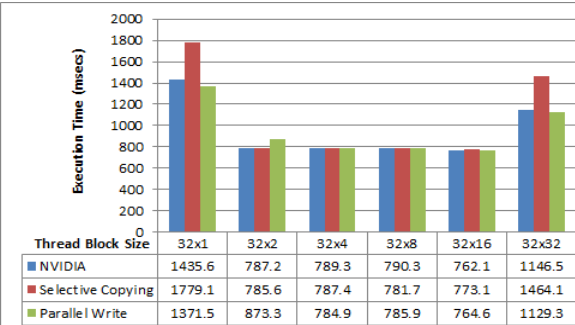
Figure 5: Exec. time for the three implementations with Tile Size = 32 x 32